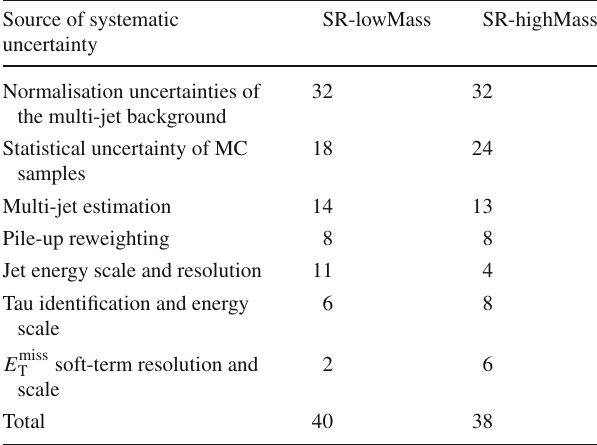
Table8 Therelativesystematicuncertainty(%)inthebackgroundesti- mate in the SR-lowMass and SR-highMass from the leading sources. Uncertainties from different sources may be correlated, and do not nec- essarily add in quadrature to the total uncertainty